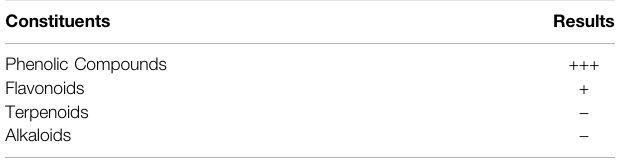
TABLE 1 | Preliminary phytochemical screening of aqueous C. brachiata leaf extract. Constituents